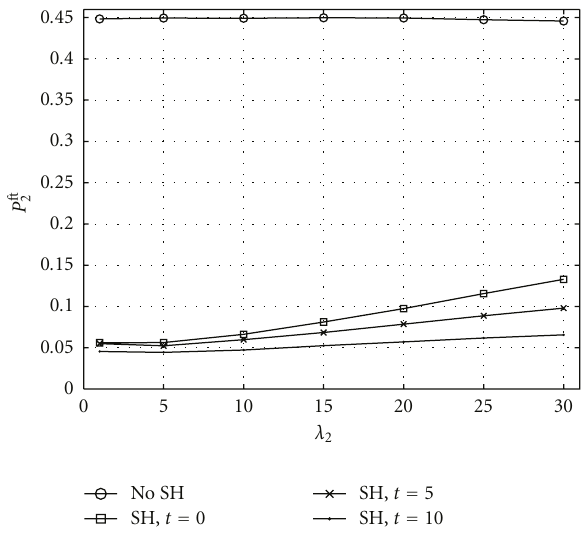
Figure 3: Forced termination of SUs with the arrival rate of SUs, when λ 1 = 4 .